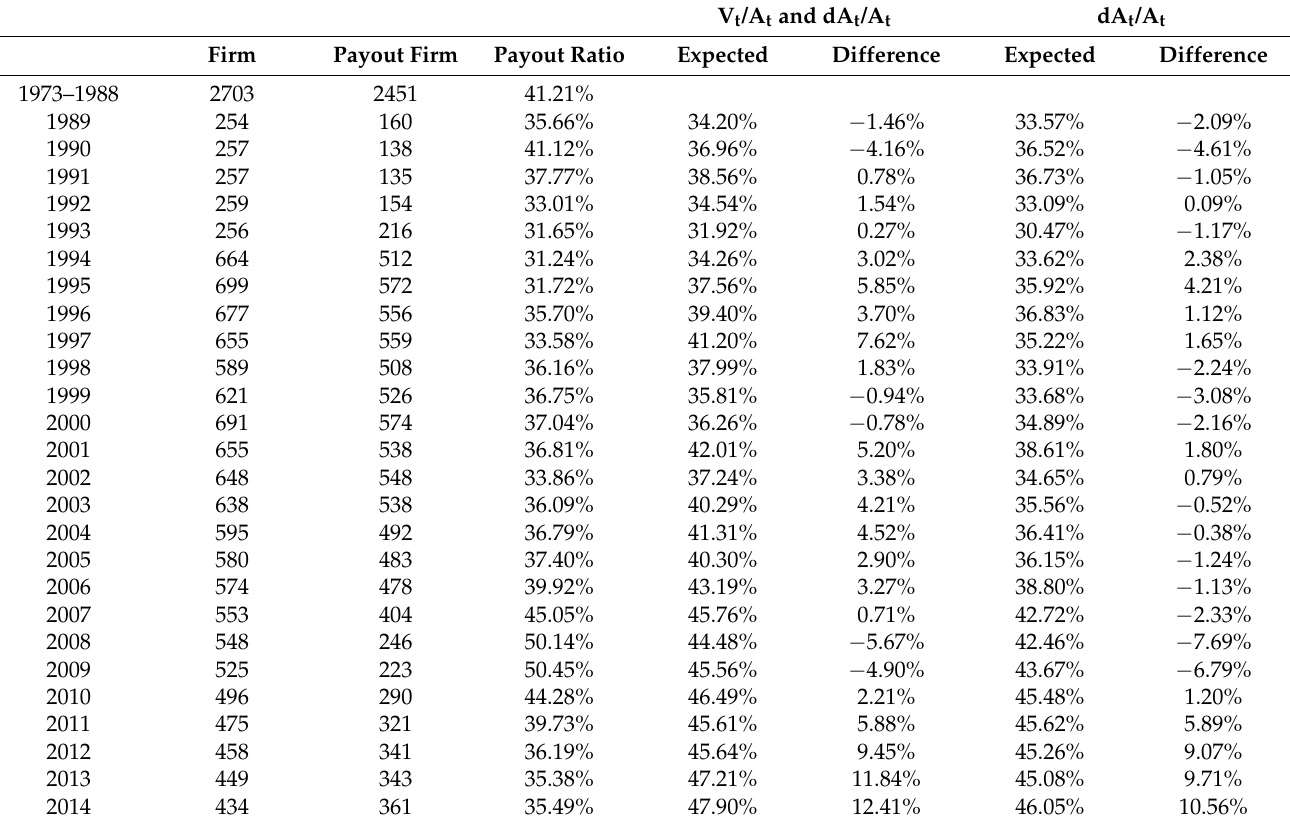
Table 8. Expected percentage of dividend payers versus actual payers based on OLS regressions in Table 7. In this table, we apply the coefficients from the OLS regressions in Table 7 estimated over the period 1973–1988 to the variable values in each year 1989–2014 to estimate the expected payout ratio in each year. We also show the actual percentage of dividend payers in each year to calculate the difference between the actual and expected percentages of dividend